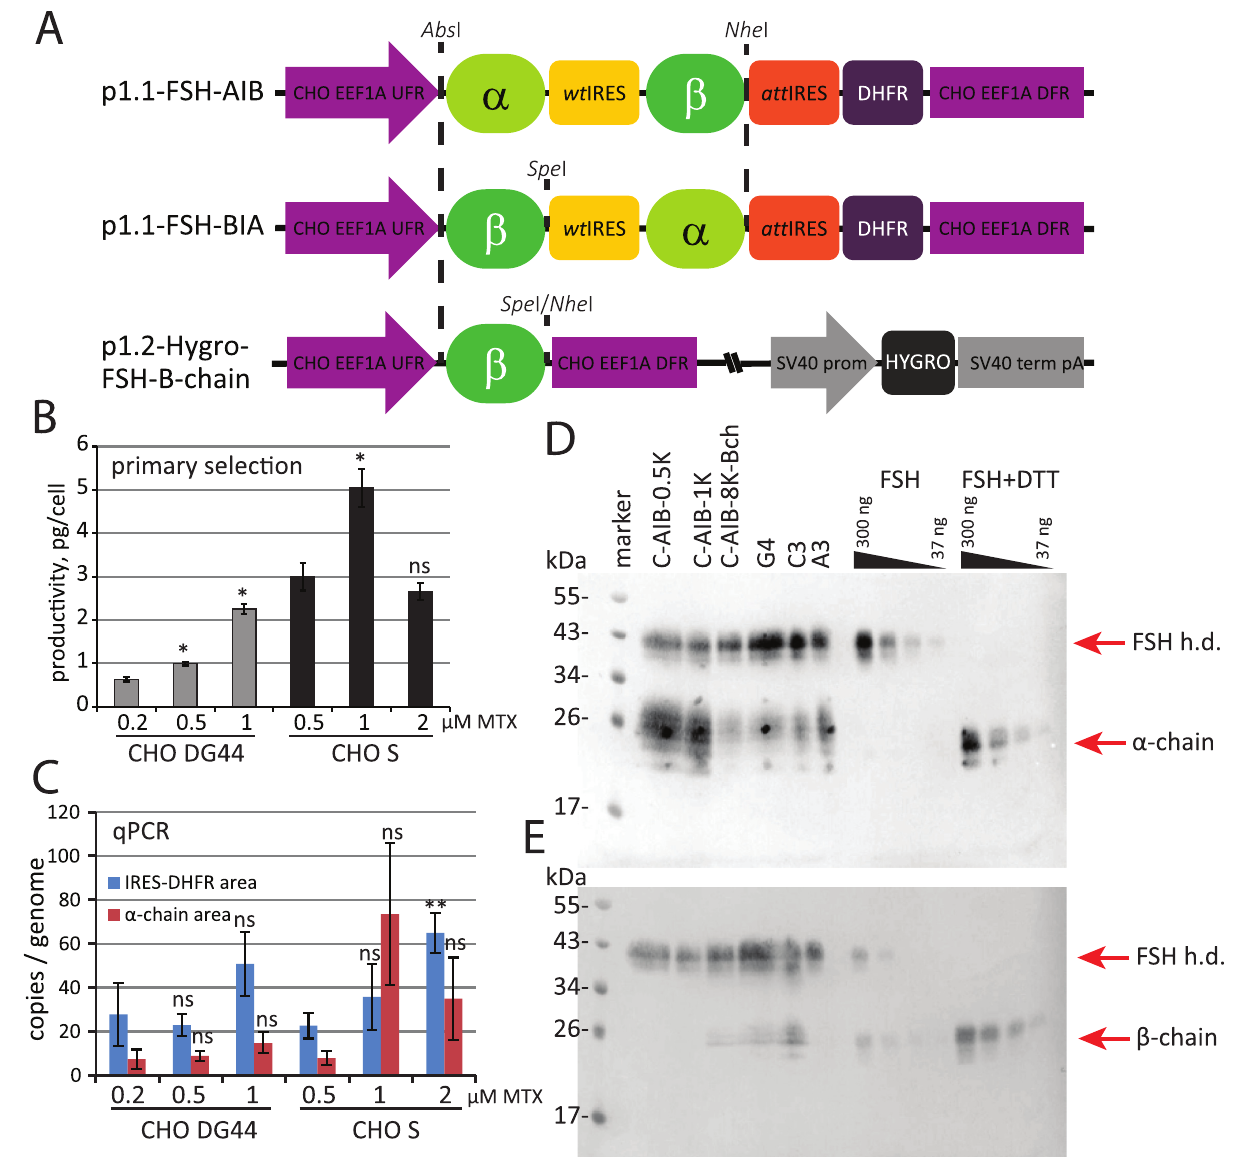
Fig 1. Scheme of the genetic constructions and the characterization of the primary stably transformed cell populations. A—Scheme of the tricistronic (p1.1-FSH-AIB, p1.1-FSH-BIA) and bicistronic (p1.2-Hygro-FSH-B-chain) expression plasmids. CHO EEF1A1 UFR—upstream flanking area of the EEF1A1 gene (elongation factor-1 α gene promoter, flanked with 5’ UTR), DFR—downstream flanking area (elongation factor-1 α gene terminator and polyadenylation signal, flanked with 3’ UTR), EMCV IRES—encephalomyocarditis virus internal ribosome entry site (wild type); attEMCVIRES—attenuated encephalomyocarditis virus internal ribosome entry site; DHFR—ORF of the dihydrofolate reductase gene, a—ORF of the FSH α -subunit; b—ORF of the FSH β -subunit, SV40 promoter—promoter of the polyomavirus simian virus 40; SV40term, pA—terminator and polyadenylation signal of the polyomavirus simian virus 40, hygroB—Hygromycin B resistance gene (hygromycin B phosphotransferase). Restriction sites used for cloning are shown in italics. B—FSH secretion level in the stably transformed cell populations by ELISA. Data are mean, n = 2, � —P-value < 0.05, �� —P-value < 0.01, ns—P-value > 0.05 by the t-test. C—qPCR analysis of the expression cassette copy numbers per haploid genome. IRES-DHFR area—RT-ID-F, RT-ID-R primer pair; a-chain area—SQ-FA-F, SQ-FA-R primer pair. All data normalized to the PPIB copy number. Error bars represent standard deviation, n = 3. D—Western blotting of secreted FSH in culture medium, antibodies to α -chain. C-AIB-0.5K—stably transfected CHO S cell line 0.5 μ M MTX, C-AIB-1K—polyclonal population obtained at 1 μ M MTX, C-AIB-8K-Bch—polyclonal population amplified up to 8 mkM MTX and additionally transfected by the p1.2-Hygro-FSH-B-chain plasmid; G4- monoclonal cell line C-P1.3-FSH-G4, C3—monoclonal cell line C-P1.3-FSH-C3, A3—monoclonal cell line C-P1.3-FSH-A3; FSH—Gonal F, FSH+DTT—Gonal F pretreated with 10mM DTT, “FSH h.d.”– FSH heterodimer. SDS-PAGE in non-reducing conditions, molecular weights are shown in kDa. E—Western blotting of secreted FSH in culture medium, antibodies to β -chain. Same samples to panel D, another membrane.